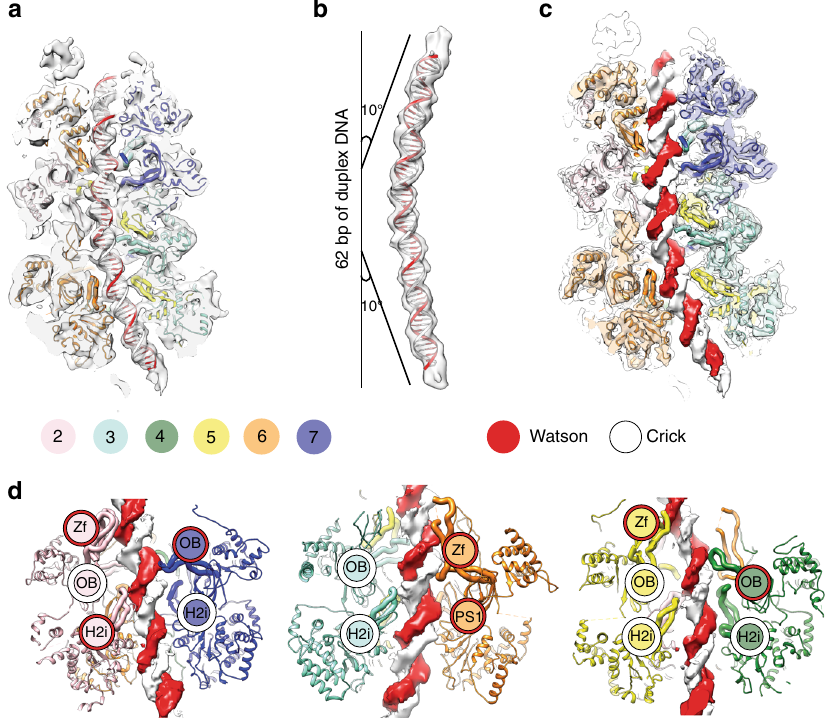
Fig. 4 Structure of the MCM double hexamer bound to duplex DNA. a Cut-through view of the cryo-EM map (6.9 Å resolution) with the re fi ned MCM atomic coordinates. Both Watson and Crick strands are touched by MCM pore loops in each single hexamer. b 62 base pairs of duplex DNA were built inside the MCM channel. The double helix bends by 10° as it enters the N-terminal dimerization domain. c Overlay between the 6.9 Å resolution, DNA- occupied structure and the higher-resolution ensemble protein structure fails to highlight detectable conformational changes in MCM upon DNA binding. A composite resolution structure can therefore be built integrating the atomic models derived from the lower resolution DNA and higher-resolution protein structures. d Detailed analysis of the MCM pore loops engaging the Watson and Crick strands. OB, oligosaccharide/oligonucleotide fold. PS1, Pre-sensor 1 hairpin. Zf zinc- fi nger hairpin, H2i